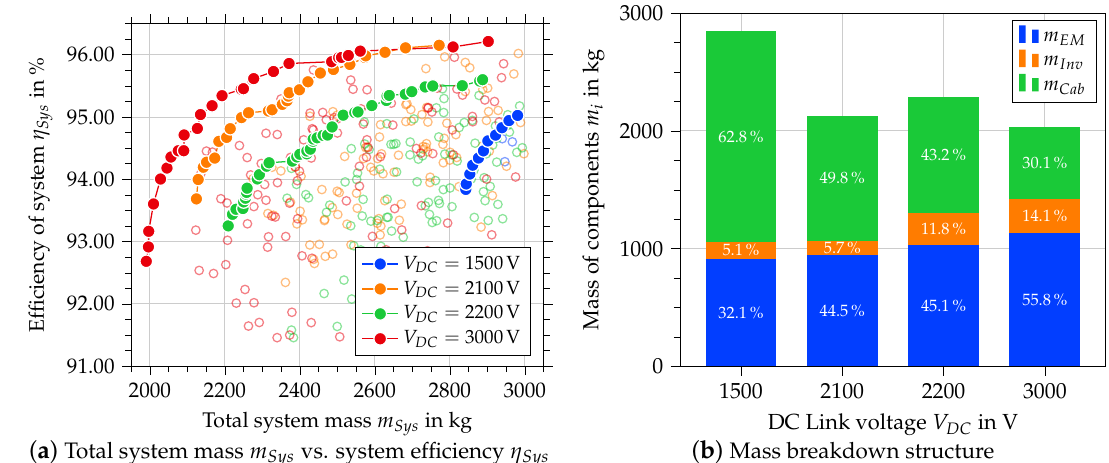
Figure 7. CENTRELINE DSE study results: ( a ) Total system mass m Sys against system efficiency η Sys of FF drive unit for different DC link voltage levels V DC . Line plots indicate Pareto-front for different voltage levels. Not all results shown for better readability ( ≈ 5%). ( b ) Breakdown of component masses m i including electric machine, inverters, and cables for Pareto-optimal point for different DC link voltages V DC at similar system efficiency η Sys ≈